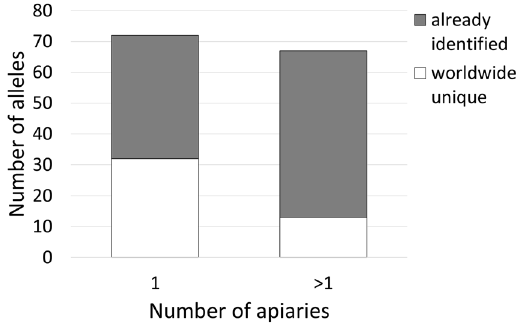
Figure 4. Identification of worlwide unique csd alleles and their distribution. Frequency of worldwide unique alleles (white bars) compared to the alleles that are already present in publicly available databases (grey bars) within the sets of csd alleles that were identified in this study and are present in 1 or > 1 apiaries. These two distributions were compared using the chi-test and were found to be significantly different (p = 3 × 10 − 6